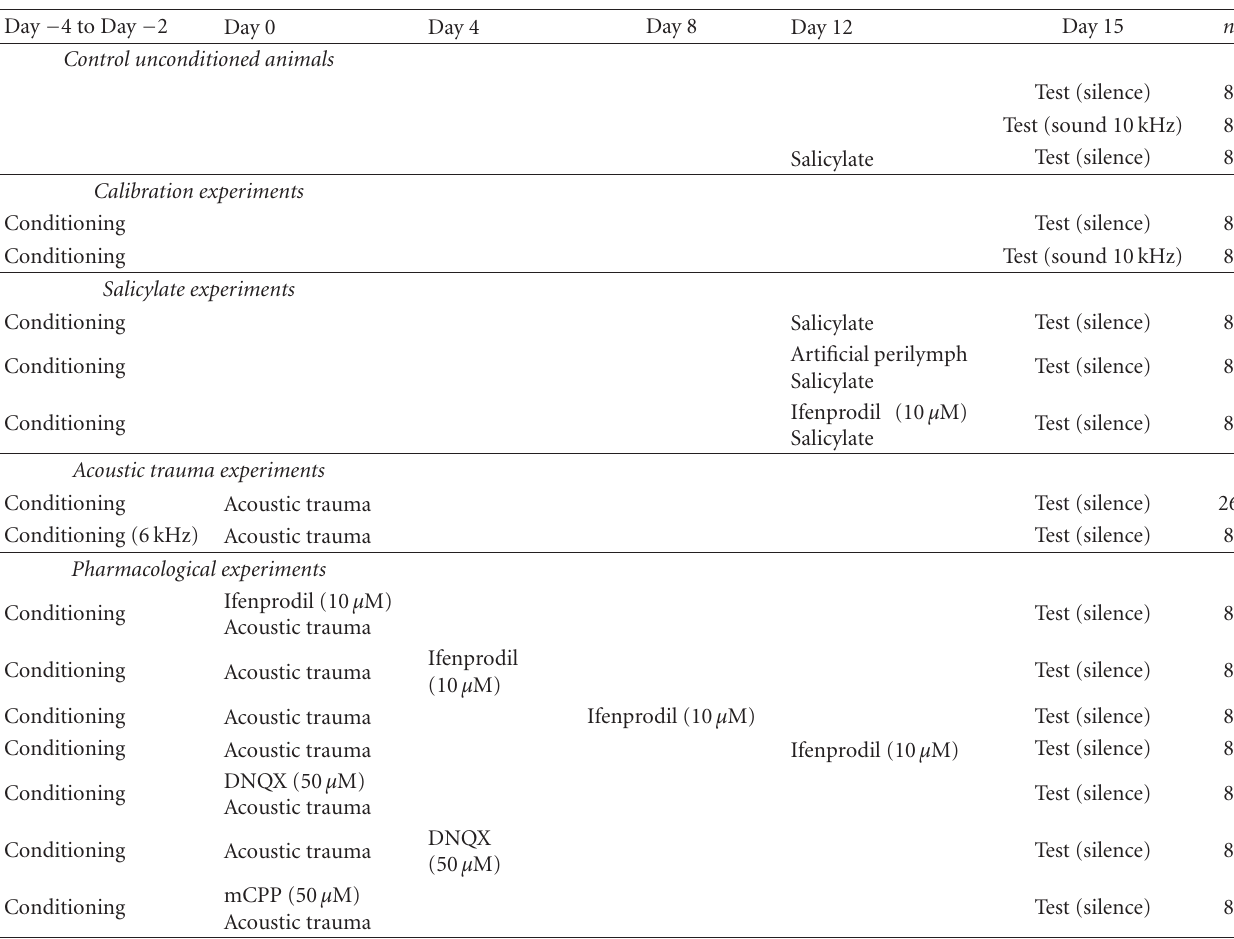
Table 1: Experimental groups . When not specified, conditioning was performed using a sound of 10kHz, as described in Section 2. Salicy- late refers to a daily injection of salicylate (300/mg/kg) between Day 12 and Day 15. Acoustic trauma refers to the day when the acoustic overexposure was performed. The name of a pharmacological agent means that this agent was locally applied within cochlear fluids at the indicated day. When a drug was applied at Day 0, the application was performed just before the sound